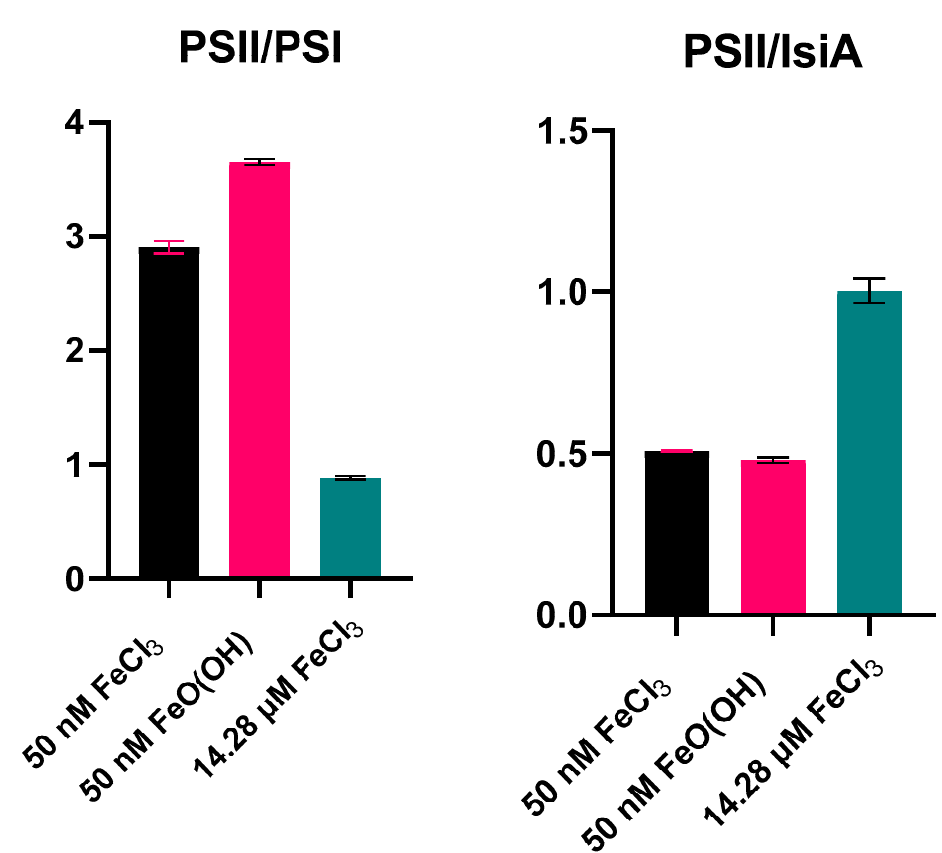
Figure 3. Pigment ratios detected with 77 K fluorescence emission. A two ‐ way ANOVA with uncorrected Fisher’s LSD showed significant differences between the PSII/PSI ratios from the two cultures ( p ‐ value: < 0.0001). The PSII/PSI ratio increased with the downregulation of PSI, and a higher ratio was evidence of a higher degree of stress response. Both ratios would be closer to 1 if no iron stress was present, as evidenced by the PSII/PSI ratio from the iron ‐ replete culture of Synechococcus (green). The PSII/IsiA ratio decreased with higher degrees of iron stress, as the signal from IsiA overshadowed that from PSII. No significant differences were found between the PSII/IsiA ratios of the FeCl 3 and FeO(OH) cultures ( p ‐ value: 0.2985), but a Synechococcus culture grown on 14.28 μ M FeCl 3 exhibited a markedly higher PSII/IsiA ratio, thus evidencing the iron stress in both of the cultures in this